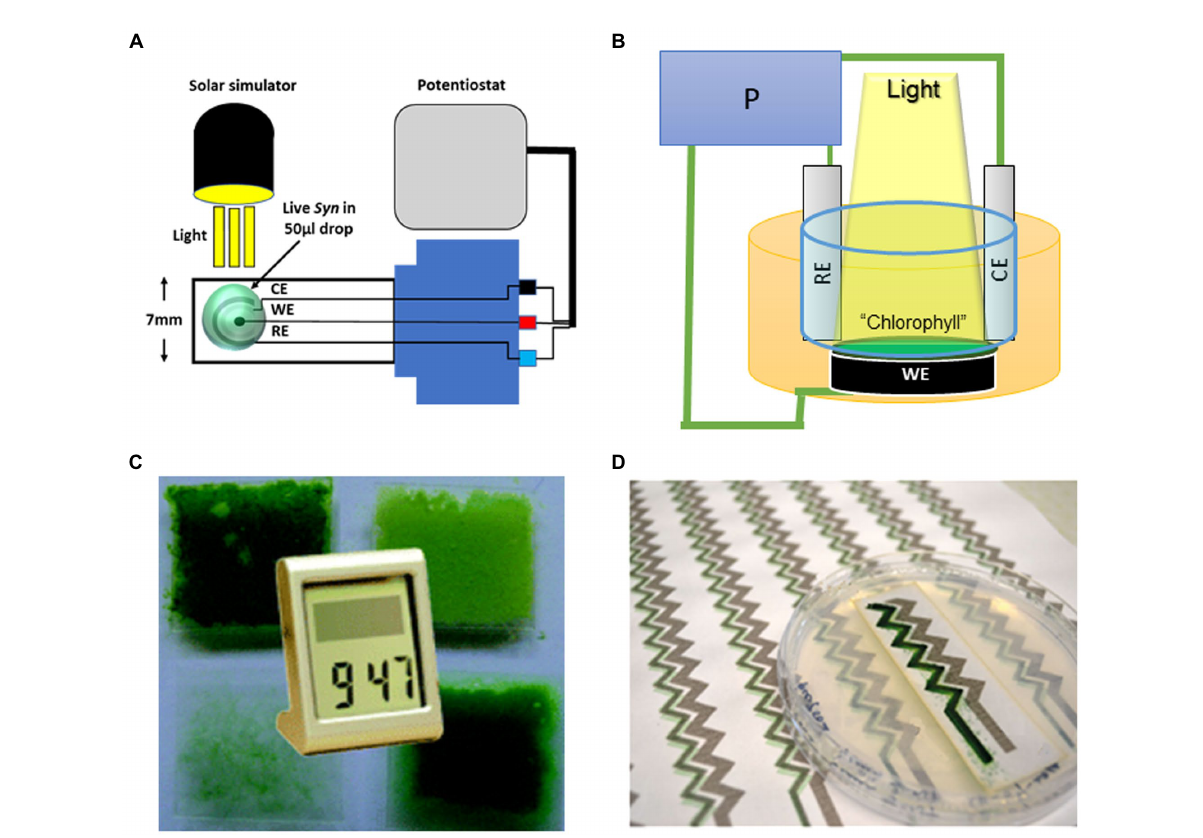
FIGURE 2 Different configurations of cyanobacterial-based BPECs. (A) The micro-sized BPEC is an assembly of microelectrodes in which the micro- organism, thylakoids, or isolated PS are layered in a drop of 50 μ l on the circled electrodes (green circle spot). The micro-sized BPEC is used in experiments of small-scaled quantities. For example, to identify the internal mediator. Light is provided from above and care is taken that the sample in the drop would not be heated or dried during the experiment. Reprinted with permission from Shlosberg et al. (2021a). (B) The general and commonly used medium-sized BPEC. This commonly used BPEC contains about 50–250 ml solution in which the photosynthetic thylakoids, microorganisms, or purified PSII or PSI, indicated in the figure as “Chlorophyll,” are layered on the anode (working electrode. WE). The cathode (CE) and the reference electrode (RE) are inserted into the solution and the three are connected to the potentiostat (P). Light is provided from the above, Reprinted with permission from Saper et al. (2018). (C) Biofilm-based BPEC in which cyanobacteria were layered in a biofilm architecture on the anode enabling the generation of enough electricity to operate a digital watch. Reprinted with permission from Sawa et al. (2017). (D) Digital printing of cyanobacteria on a paper using regular ink printer in the construction of a special BPEC. Reprinted with permission from McCormick et al.